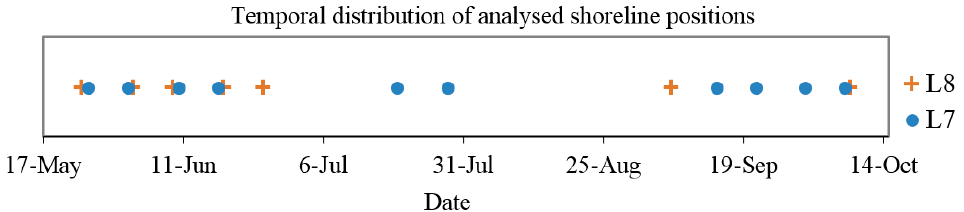
Figure 1. Temporal distribution of the data used during a five-month study (May to October 2016) when shoreline GPS measurements were also carried out. Seventeen Landsat scenes were used to extract the sub-pixel shorelines.